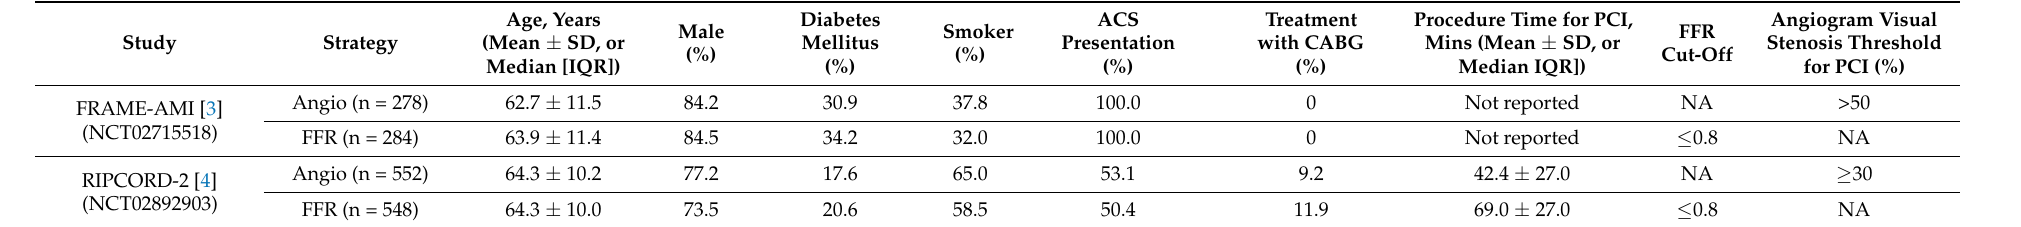
Table 2. Patient and procedural characteristics from RCTs, comparing FFR with angiography only, for guiding